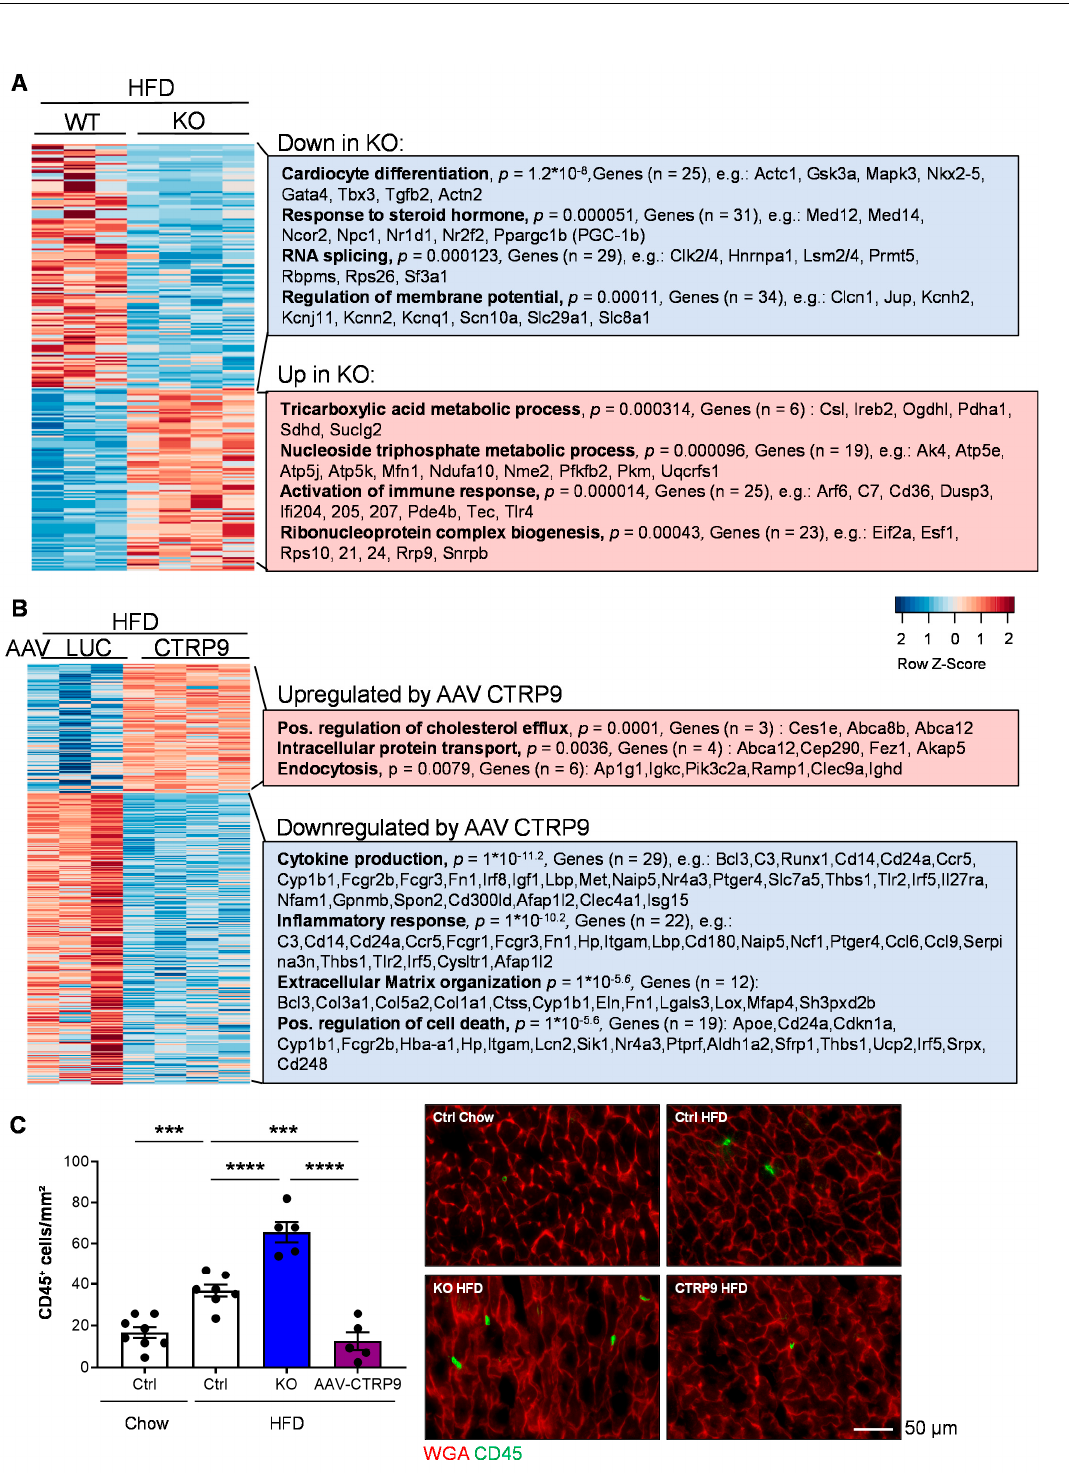
Figure 8. CTRP9 acts as an anti-inflammatory mediator in mouse hearts during high-fat diet. ( A ) Transcriptomic profiling from hearts of wild-type (WT) and CTRP9 knock-out (KO) mice after 12 weeks of high-fat diet (HFD). A heat map of differentially expressed genes is shown. Gene-ontology classes of differentially downregulated and upregulated genes and example genes are shown on the right. ( B ) Transcriptomic profiling from the hearts of AAV-Luc- and AAV-CTRP9-treated mice after 12 weeks of HFD feeding. Gene-ontology classes of differentially downregulated and up-regulated genes and example genes are shown on the right. ( C ) Quantification of the myocardial abundance of CD45+ leukocytes in the indicated mice and representative images. *** p < 0.001, **** p <